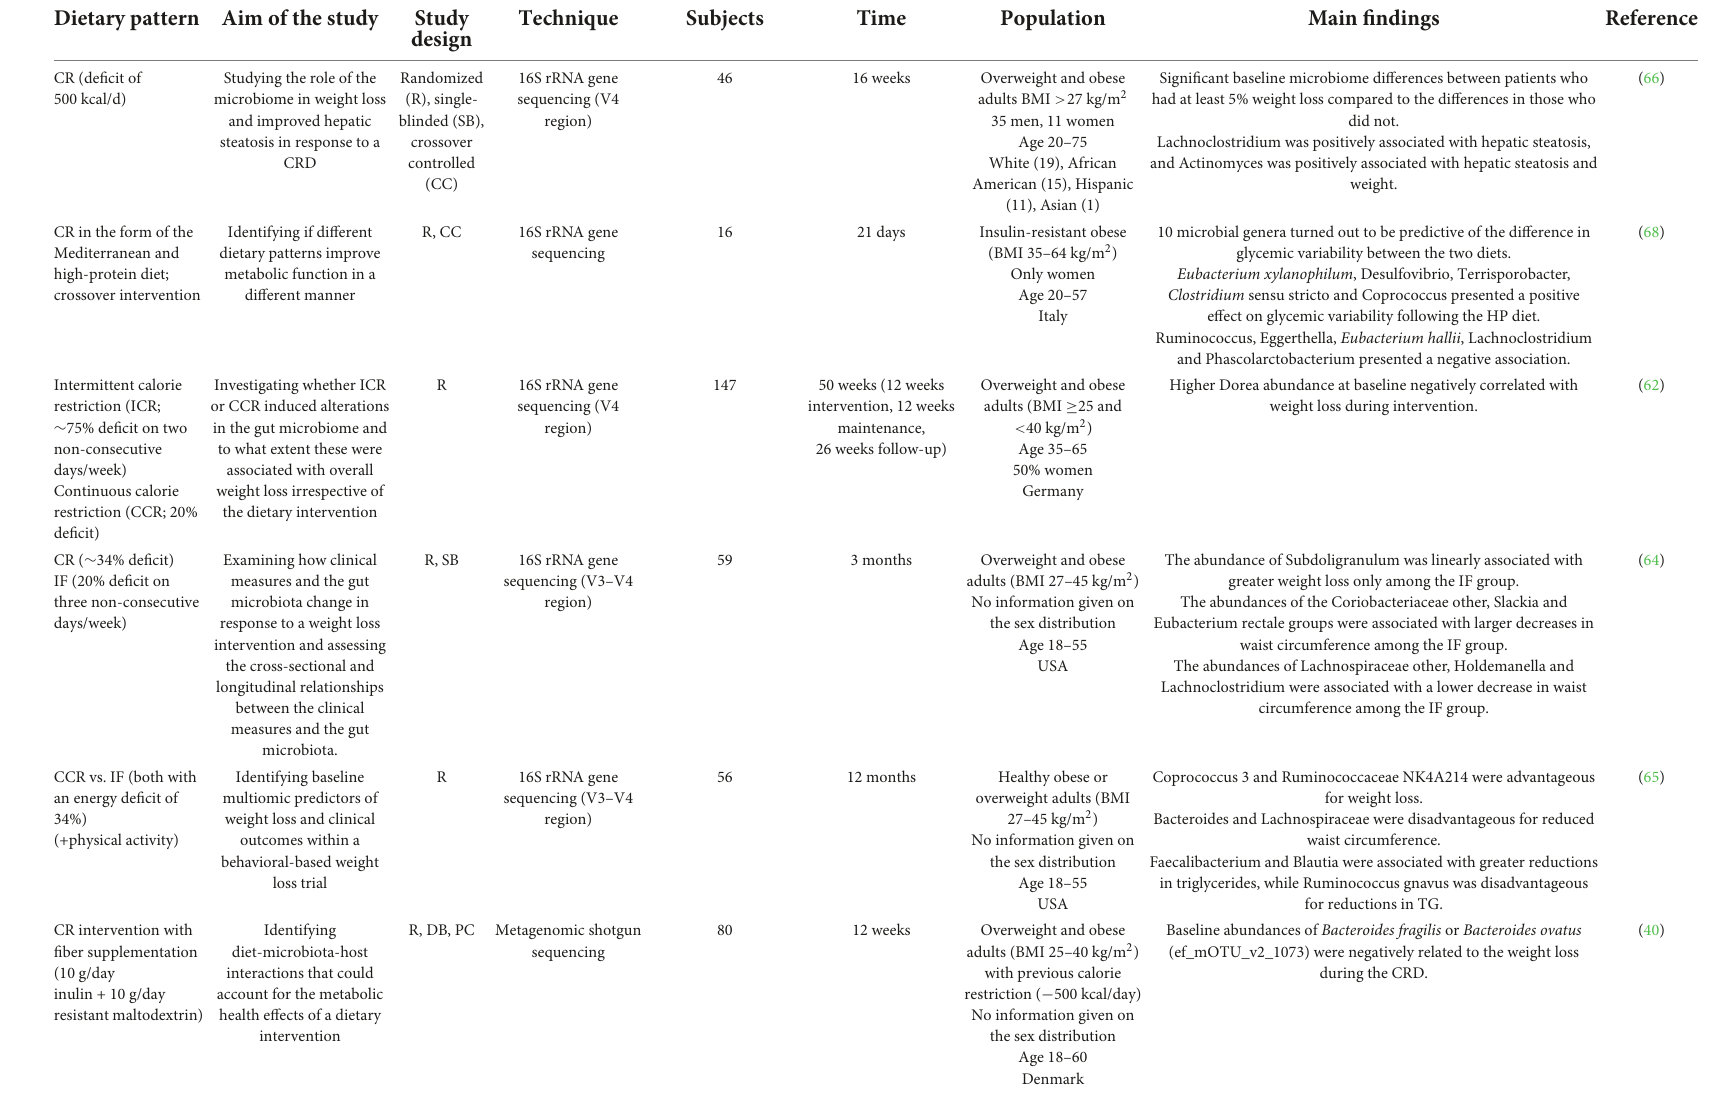
TABLE 1 Summary of human studies investigating the predictive potential of the baseline microbiota on dietary intervention success. Dietary pattern Aim of the